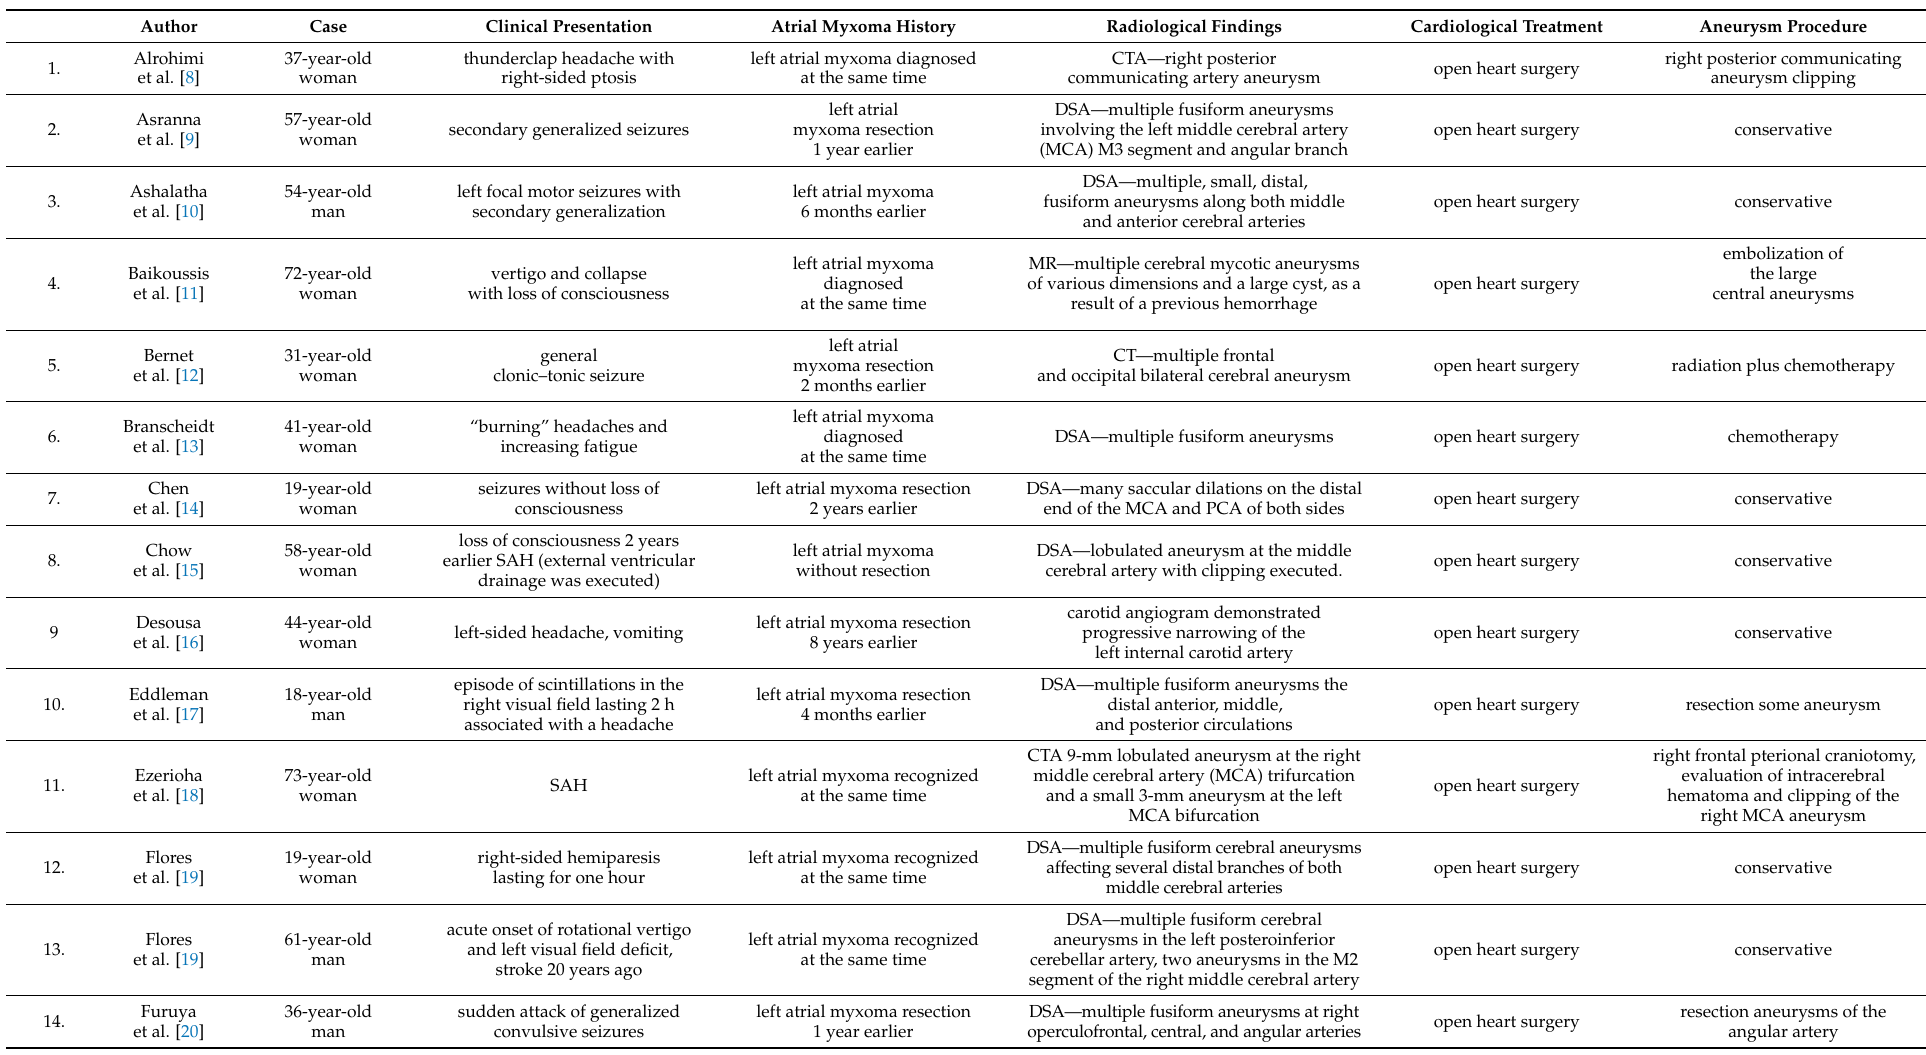
Table 1. Overview of cases of cerebral aneurysms in atrial myxoma from the